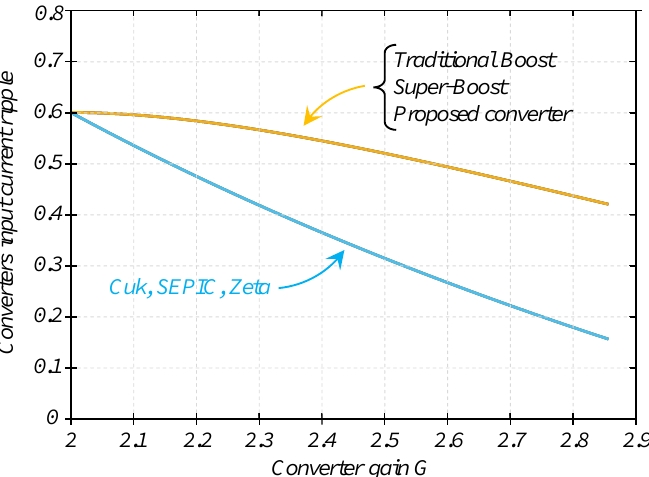
Figure 17. Input current ripple for all solutions in the full operation range vs. the converter gain G; they were designed to have an input current ripple of 0.6 A in the worst case; for all converters, the worst case is when G = 2.